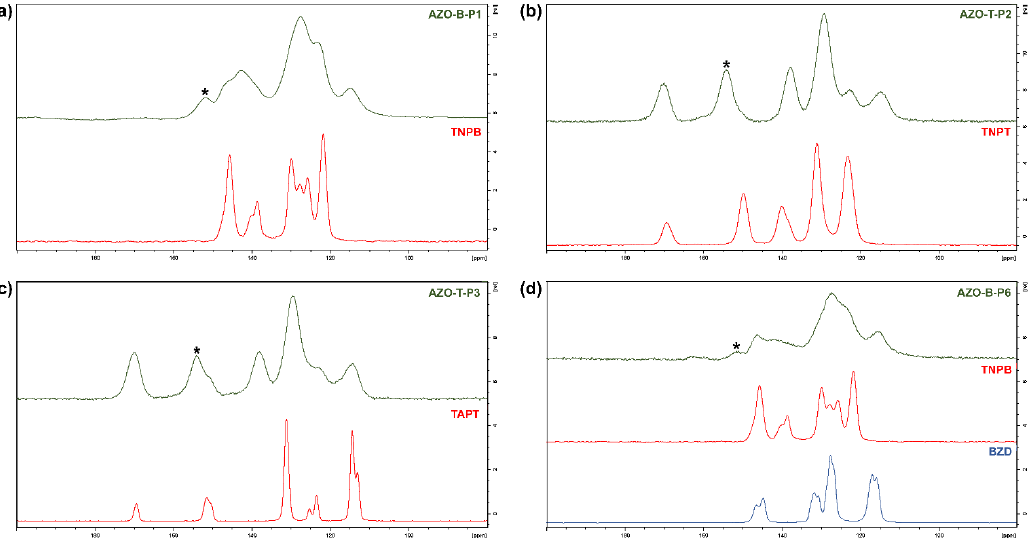
Figure 3. Comparison of representative 13 C CP/MAS NMR spectra of ( a ) AZO-B-P1 polymer and starting nitro monomer (TNPB); ( b ) AZO-T-P2 polymer and starting nitro monomer (TNPT); ( c ) AZO-T-P3 polymer and starting amino monomer (TAPT); ( d ) AZO-B-P6 polymer and starting nitro and amino monomers (TNPB and benzidine, respectively). Marked with asterisk (*) is the signal of carbon directly bonded to the azo group (−C−N=N−).